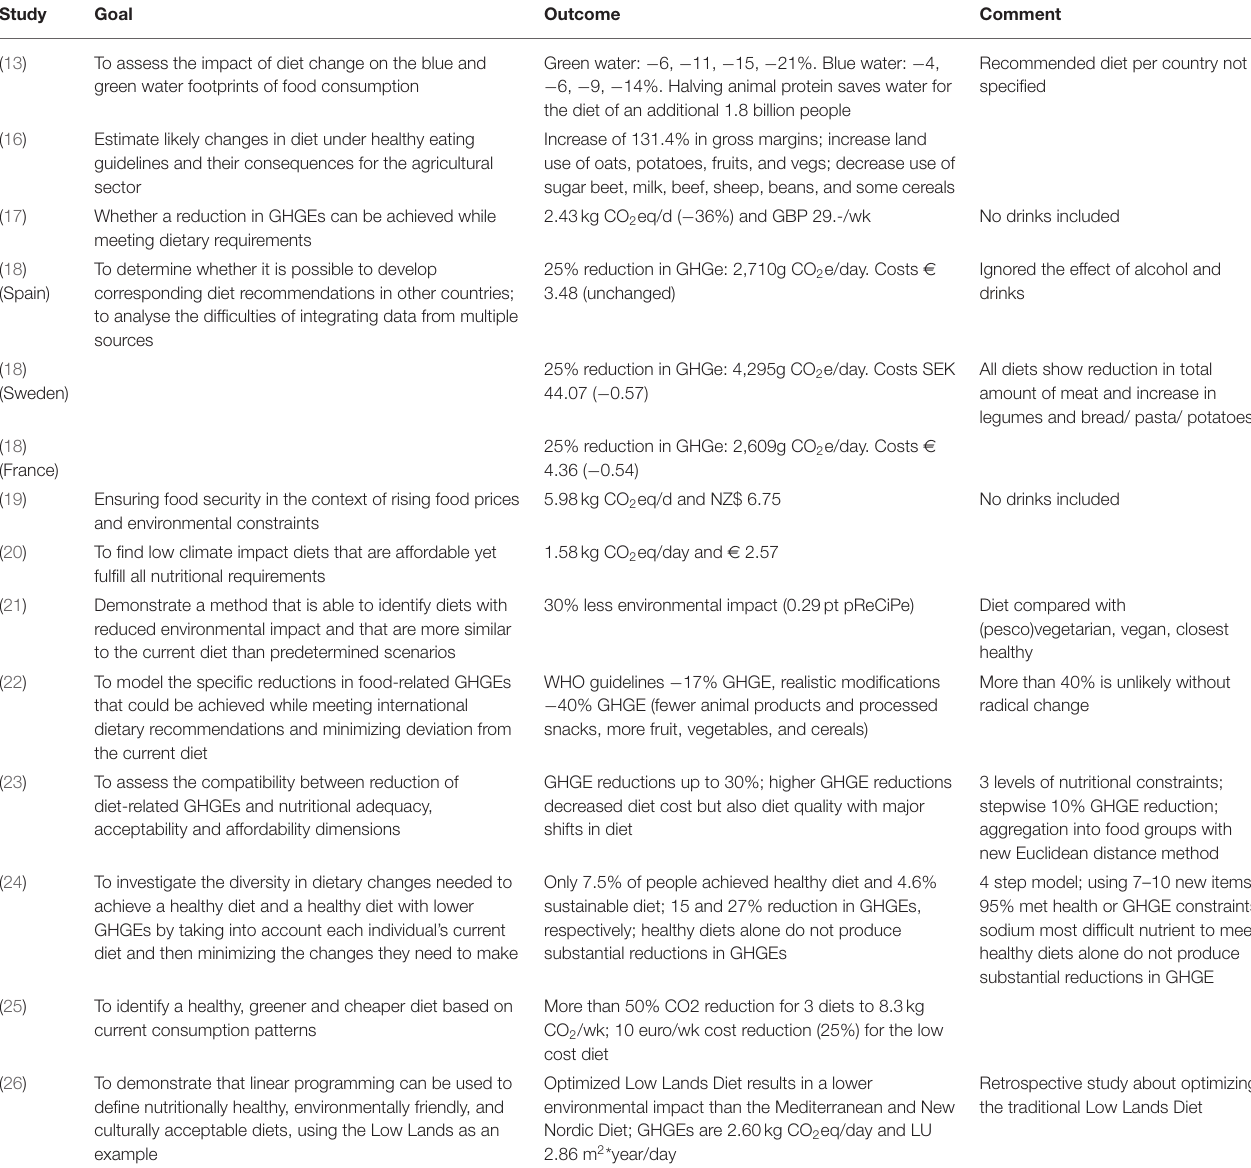
TABLE 1 | Overview of the 12 diet studies with both nutritional and ecological constraints. Study Goal